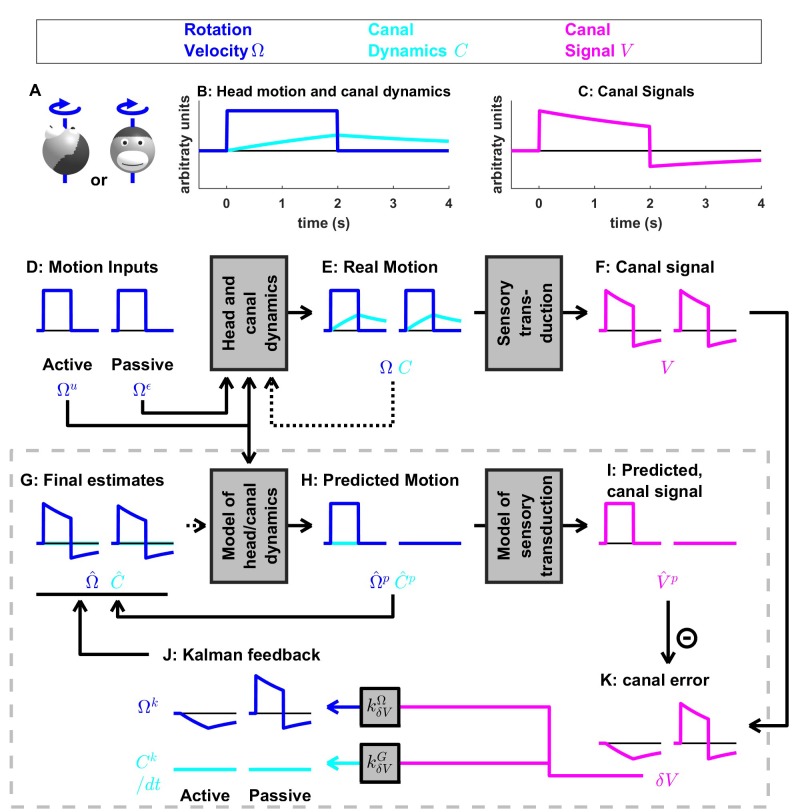
Same simulation as in Figure 4, where the internal model of canals dynamic is not used.Note error in the final estimate of rotation (G) during both active and passive movements.